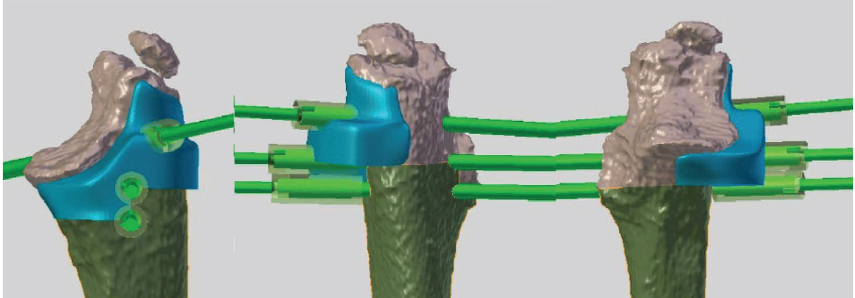
Figure 4: Te same patient mentioned in Figure 1. Te PSI for allograft cutting is placed at the medial side of the proximal ulna and is fxed by K-wires. It allows performing the step cut according to the planning. Left: medial view; middle: posterior view; right: anterior